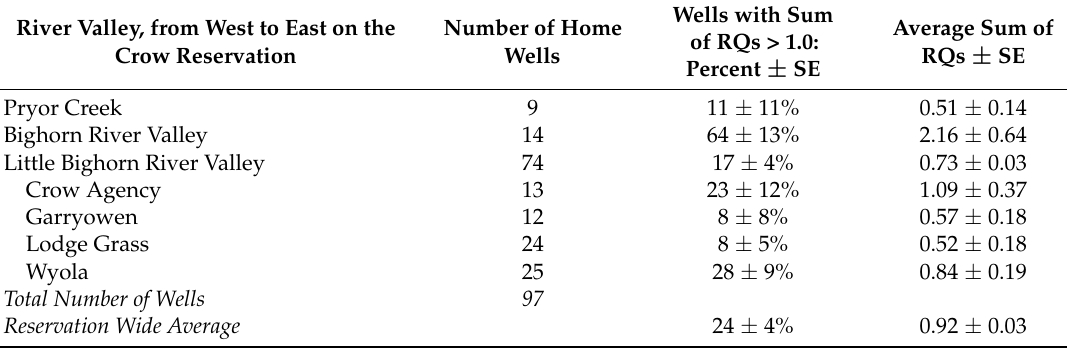
Table 5. Percentages of wells with Sum of RQs exceeding 1.0 for Mn, U, As and NO 3 − , by river valley and by ZIP codes within Little Bighorn River